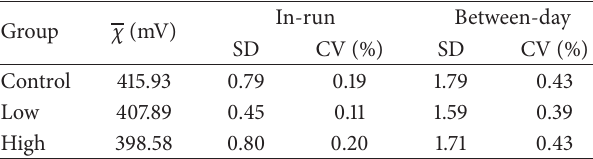
Table 1: The determination of precision for I 2 /KI redox potential